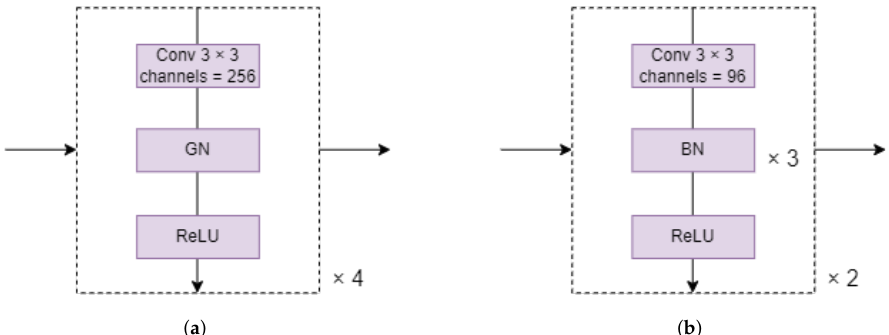
Figure 5. ( a ) Original detection head and ( b ) our optimized detection head. The convolution layers in the original detector head and the optimized detector head are 4 and 2, respectively, and the number of input channels are 256 and 96, respectively. The original detection head consists of a 3 × 3 convolution layer, a GN layer, and ReLU, while our optimized detection head consists of a 3 × 3 convolution layer, three BN layers, and